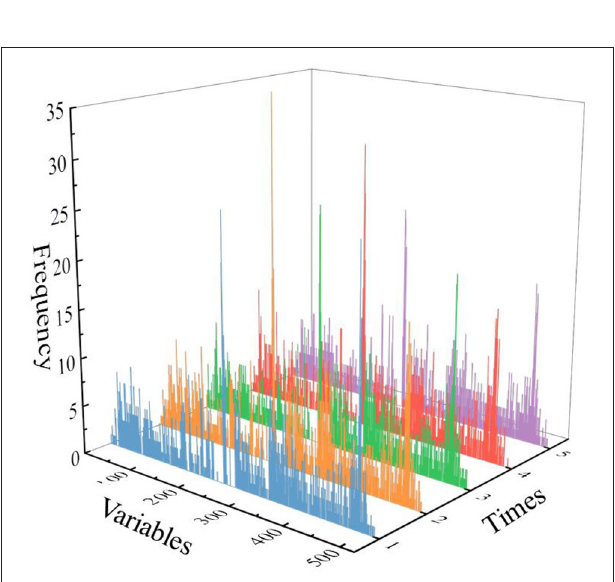
FIGURE 5 | The frequency of every variable of genetic algorithm (GA) for five